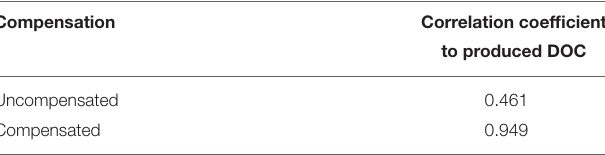
TABLE 4 | Correlation coefficients using compensated and uncompensated